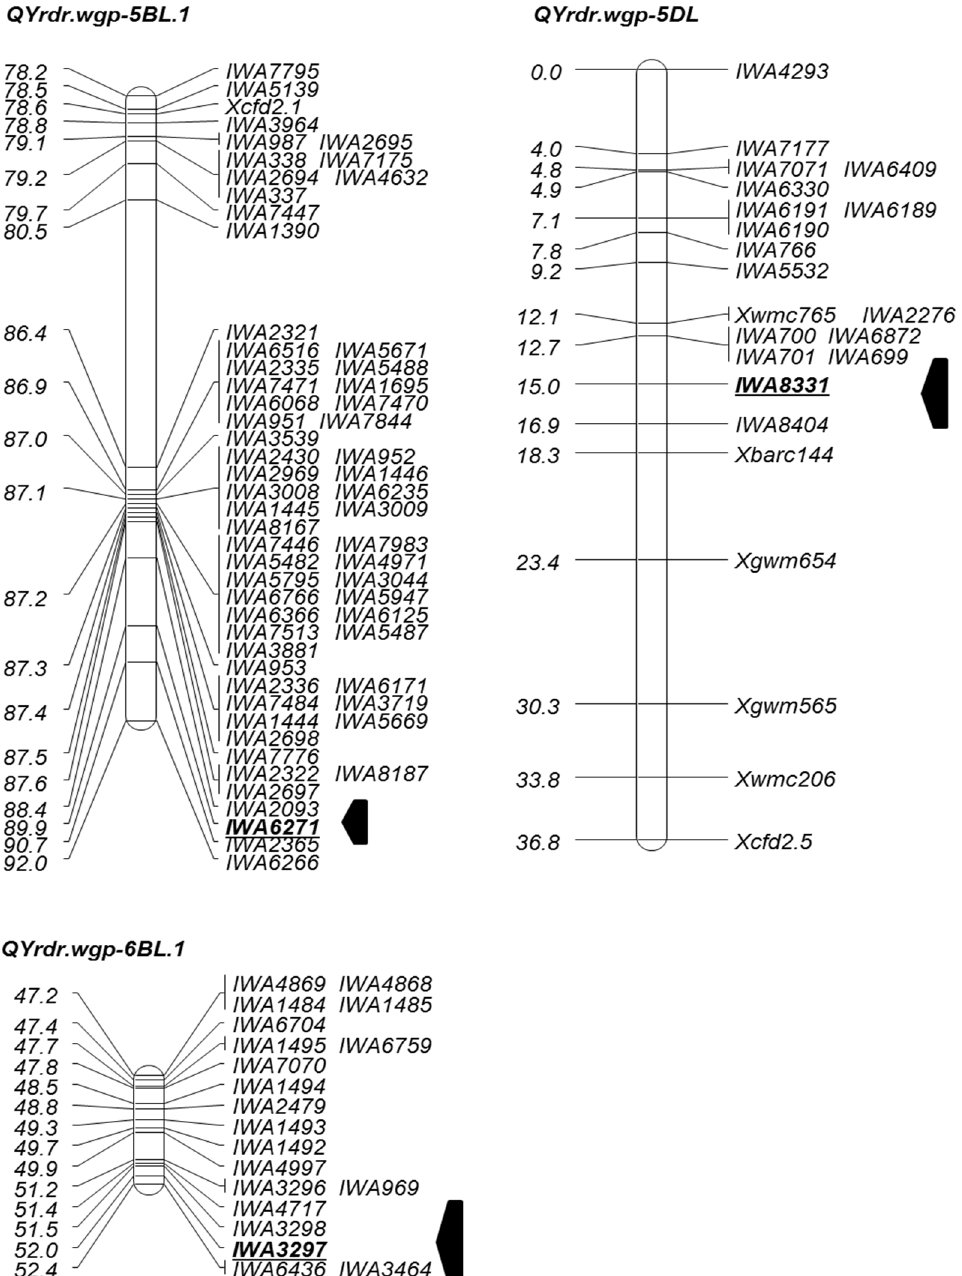
Fig 3. Linkage maps for race-specific all-stage resistance QTL QYrdr . wgp-5BL , QYrdr . wgp-5D and QYrdr . wgp-6BL . 1 constructed using the stripe rust phenotypic data obtained in the greenhouse seedling tests with different Puccinia striiformis f. sp. tritici races and simple sequence repeat (SSR) and single nucleotide polymorphism (SNP) markers of the recombinant inbred lines of Druchamp × Michigan Amber. Markers with prefix X and SSR markers and those with prefix IWA are SNPs markers. The locations of the QTL are indicated by the arrows and the markers in